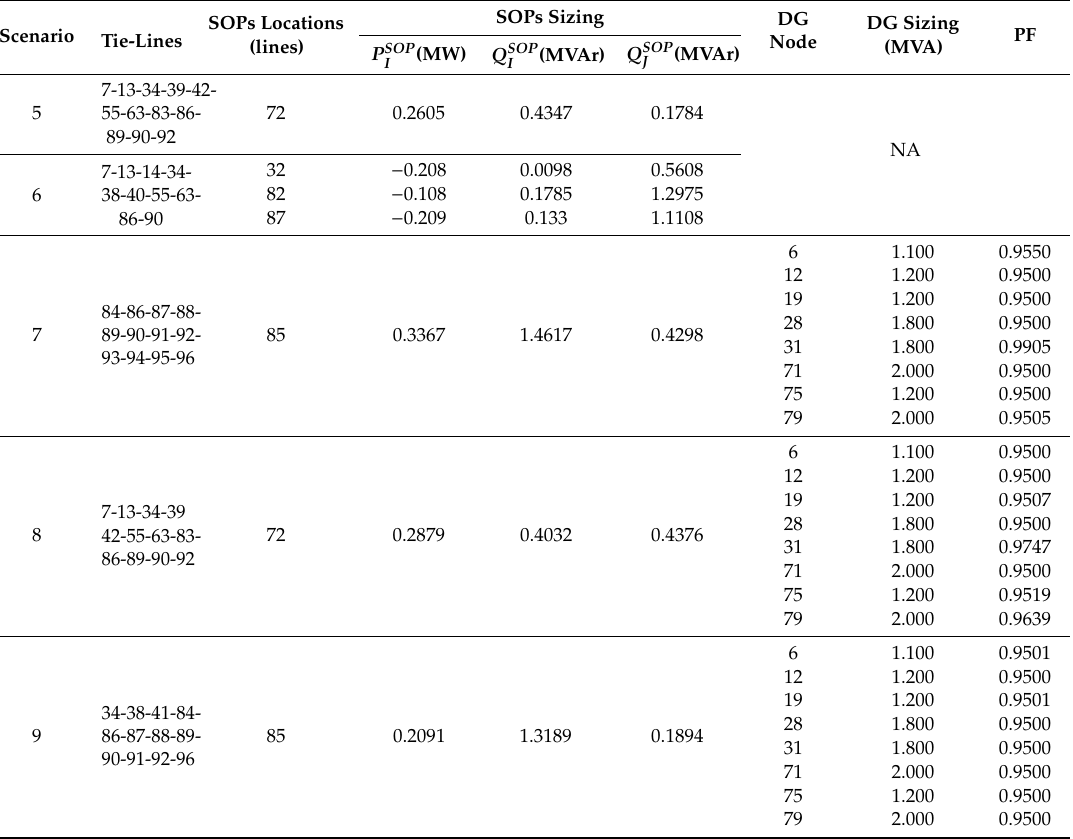
Table A4. Optimal system configuration, sizing, and locations of SOPs and DGs for scenarios 5 to 9 with SOPs internal losses considered at normal loading level: 83-node distribution